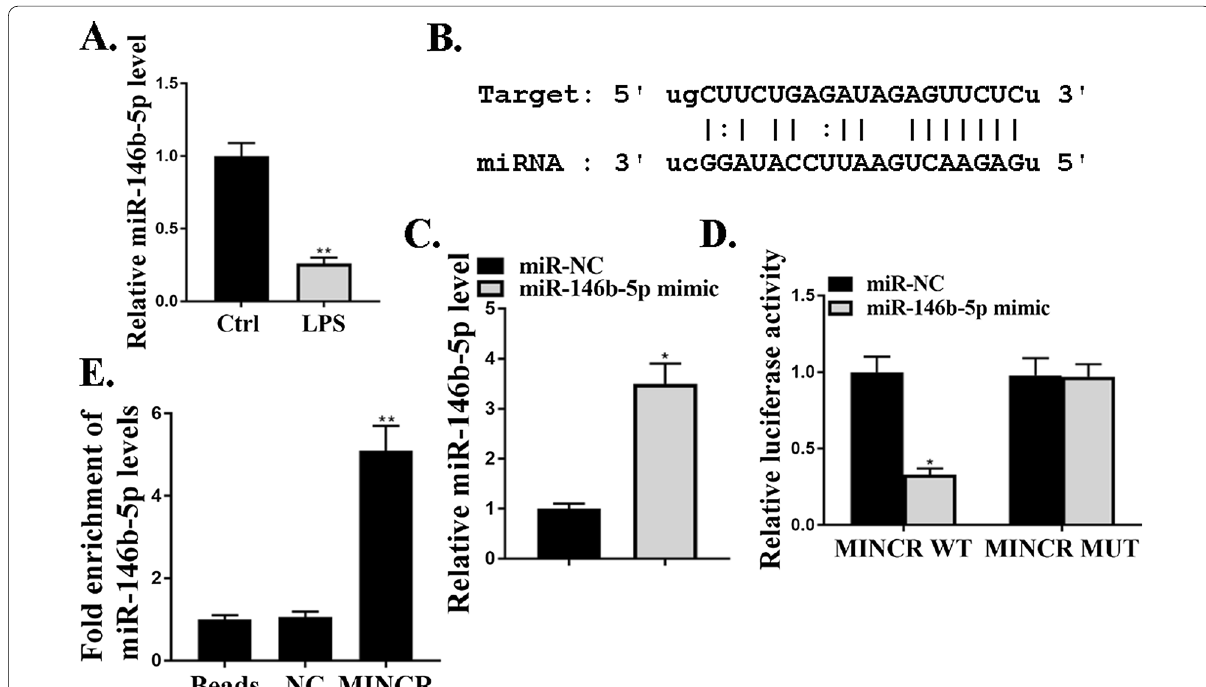
Fig. 3 MiR-146b-5p directly regulated MINCR. A miR-146b-5p expression level in a model of acute lung injury (ALI) induced by lipopolysaccharide (LPS), N 10. B MiR-146b-5p was predicted as a potential target of MINCR ( C ) miR-146b-5p expression level after mimic treatment. D analysis of = luciferase activity in cells co-transfected with MINCR-wild type (WT) or MINCR-Mut vector. E immunoprecipitation test was used to determine the enrichment of MINCR and miR-146b-5p in the immunoprecipitation complex. Bars indicated standard deviation. * P < 0.05, ** p < 0.01, N